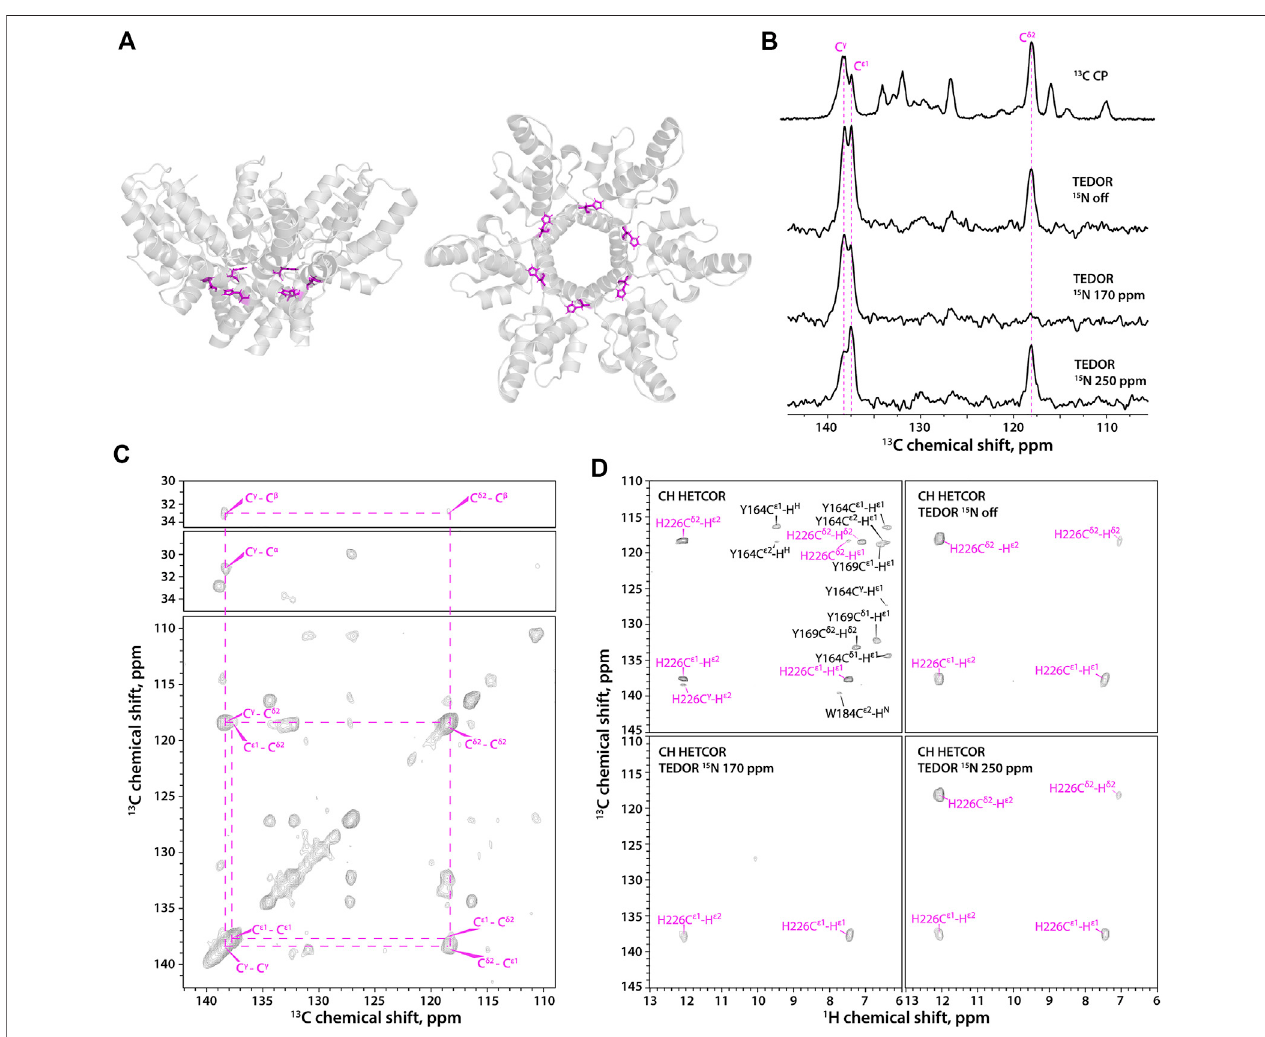
FIGURE 2 | (A) A hexameric unit of HIV-1 CA CTD -SP1 in the microcrystalline assembly (PDB 5I4T) shown as side view (left) and top view (right) . (B) 1D 13 C MAS NMR spectra of FD- 13 C, 15 N-CA CTD -SP1 with TEDOR-based 15 N selective fi ltering in the aromatic region. Top to bottom: CPMAS spectrum; TEDOR-based 15 N selectively fi ltered spectra with soft pulse turned off, soft pulse at 170 ppm, and soft pulse at 250 ppm. (C) 2D CORD spectrum of FD- 13 C, 15 N-CA (D) Aromaticregionsof 1 H-detectedTEDOR-based 15 Nselective fi lteredCHHETCORspectrainFD- 13 C, 15 N-CA CTD -SP1:TEDOR fi lterandsoftpulseturnedoff (topleft) , soft pulse turned off (top right) , soft pulse at 170 ppm (bottom left) , soft pulse at 250 ppm (bottom right) . The MAS frequency was 40 kHz in all experiments, unless indicated otherwise. Signals of τ tautomer are shown in magenta.